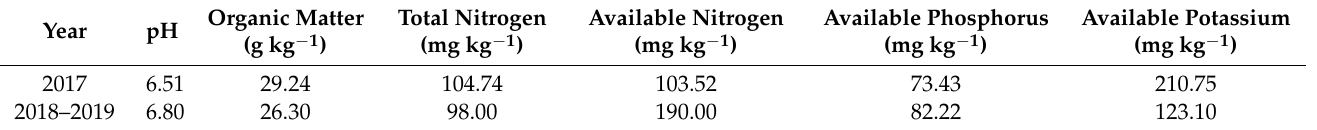
Table 4. Soil basic fertility characteristics.